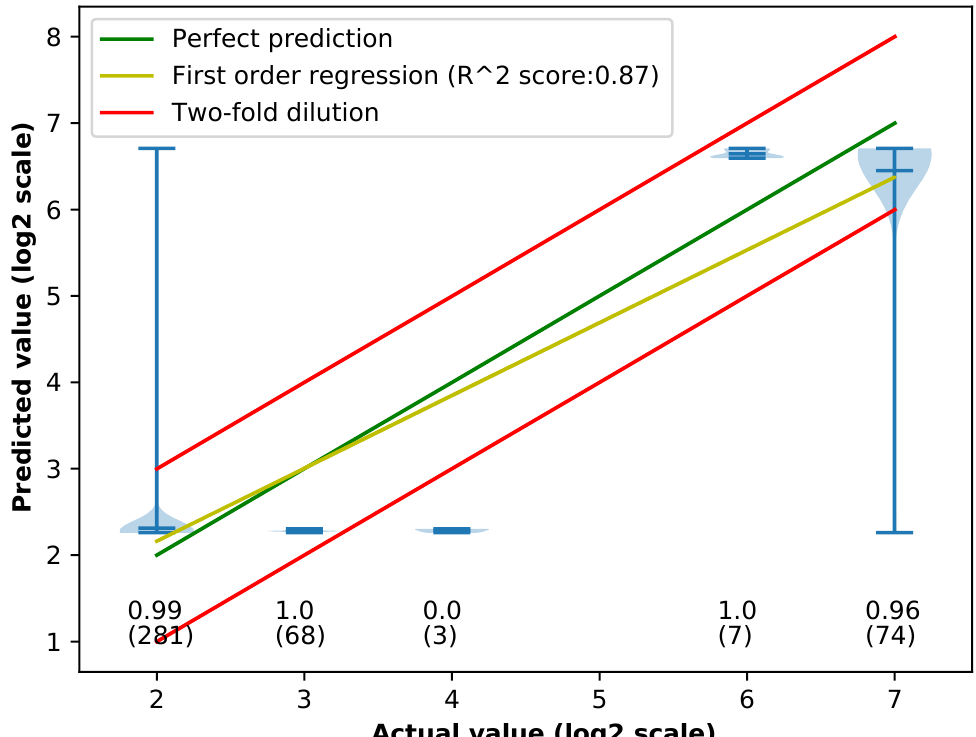
Figure A7. C. jejuni and nalidixic acid. Amino acid 5-mers. Violin plots of performance using only one 5-mer (“GDTAV”). X-axis is the actual value and y-axis is the predicted value. Each violin shows the kernel density estimation distribution of predictions for one target value. Below each violin, the ± 1 two-fold dilution accuracy of that target value is mentioned, and below that, the number of strains with that target value is mentioned in parentheses. The green line represents the perfect prediction and the yellow line represents the first order regression between the actual values and predicted values. The red lines represent the limits of ± 1 two-fold